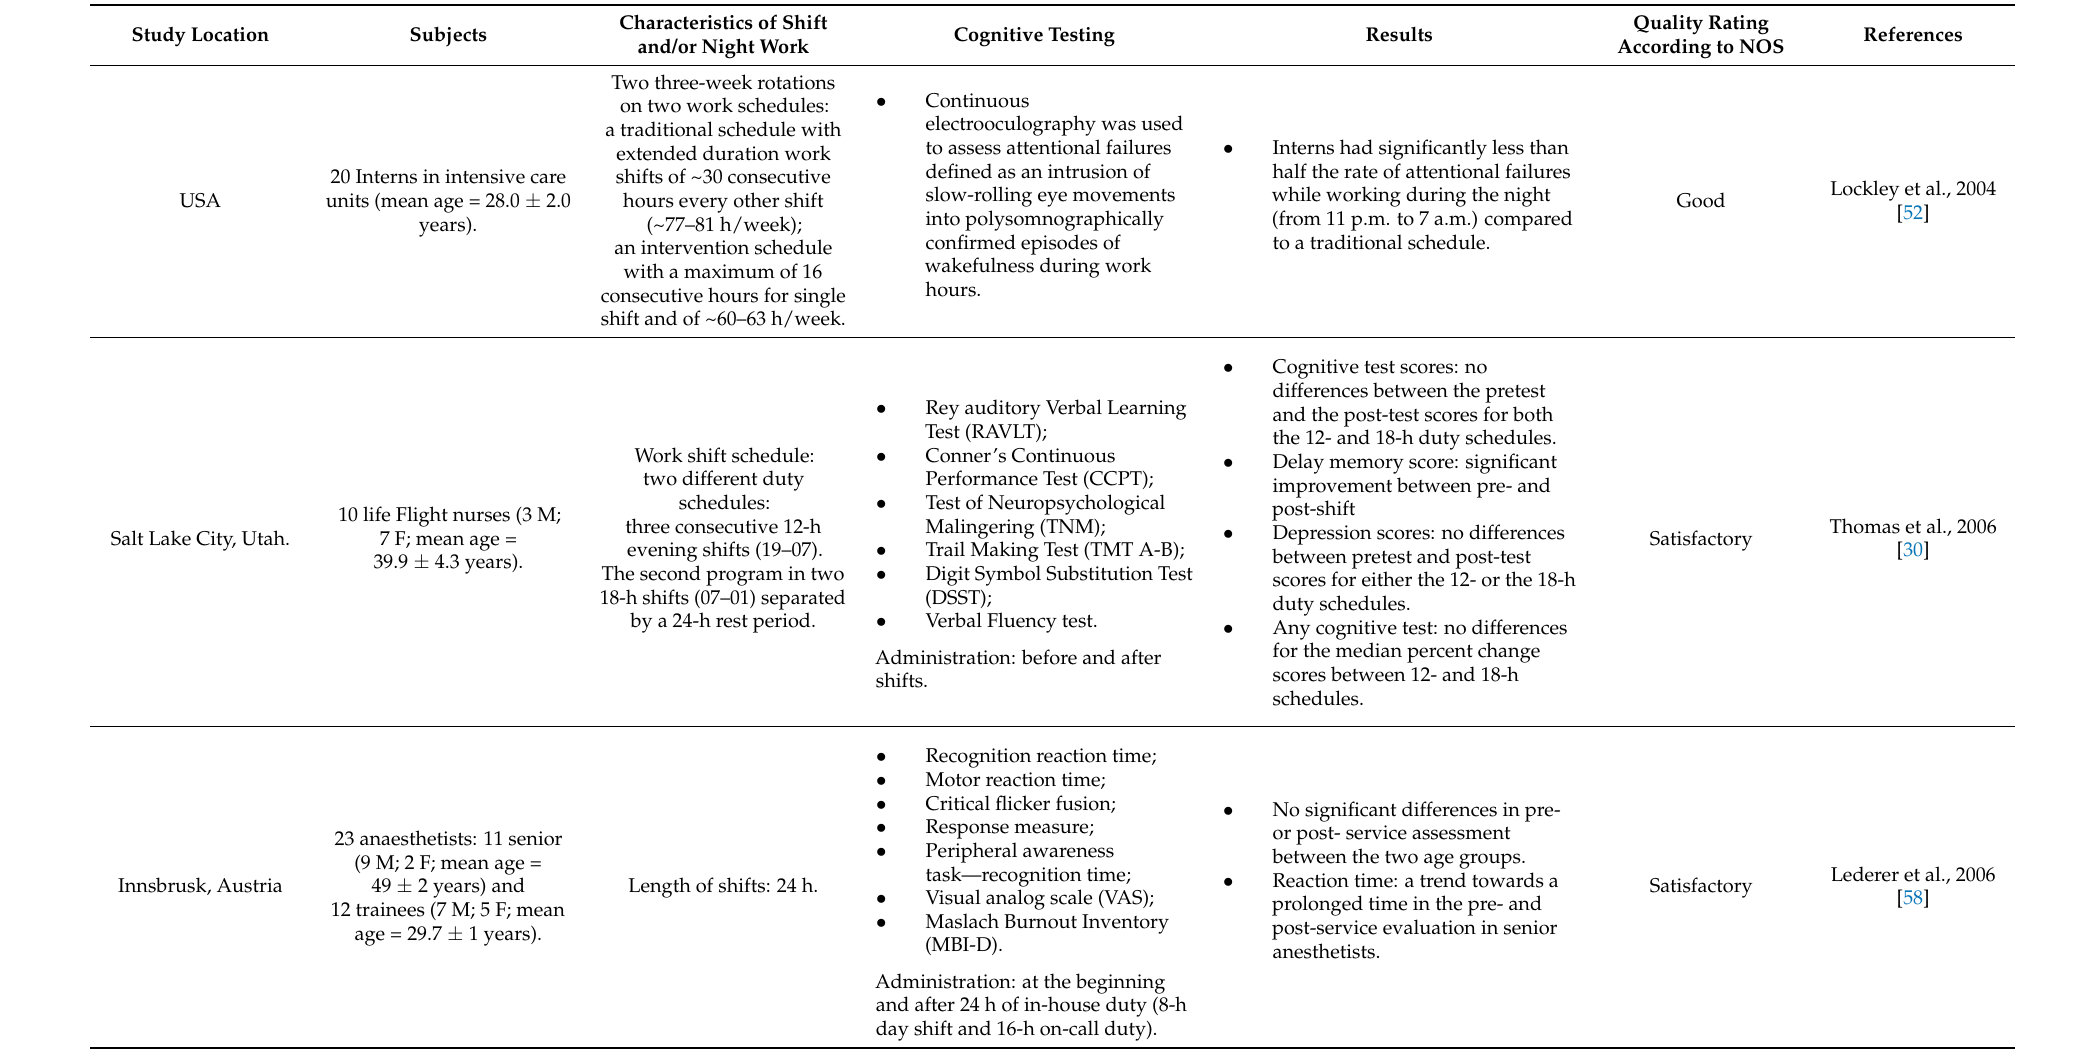
Table 4. Studies addressing the effects of long working hours on cognitive